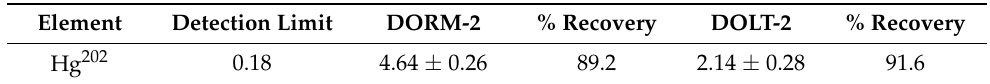
Table 2. Detection limit value (ng g − 1 ), reference materials values ( µ g g − 1 ), and percentages of recovery